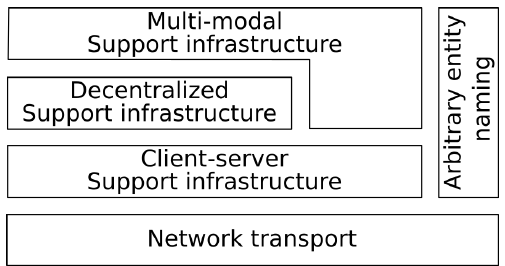
Figure 1. An architectural view of the components presented in this